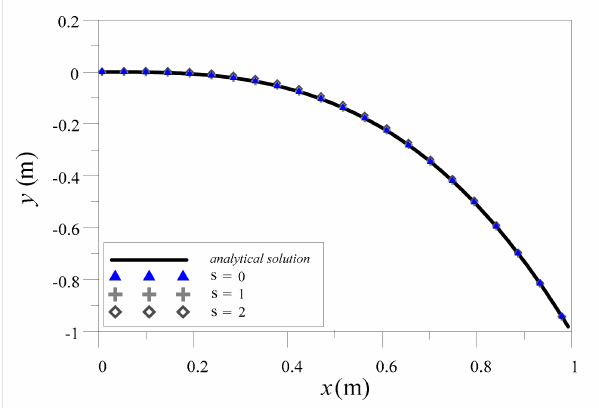
Figure 19. Comparing of the numerical solutions of the proposed method and the exact solution along Γ 1